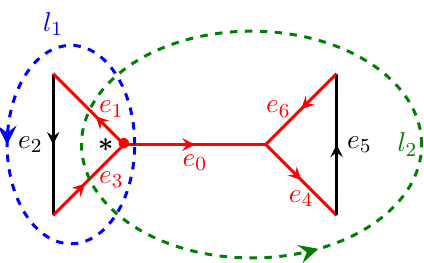
Figure 1 . Illustration of possible sets of generators of π 1 ( X 1 ; X 0 ) for a certain space X . Edges are depictured by continuous lines, with a maximal tree distinguished by the red color. Two independent loops based at the point ∗ (the big dot) are indicated by dashed